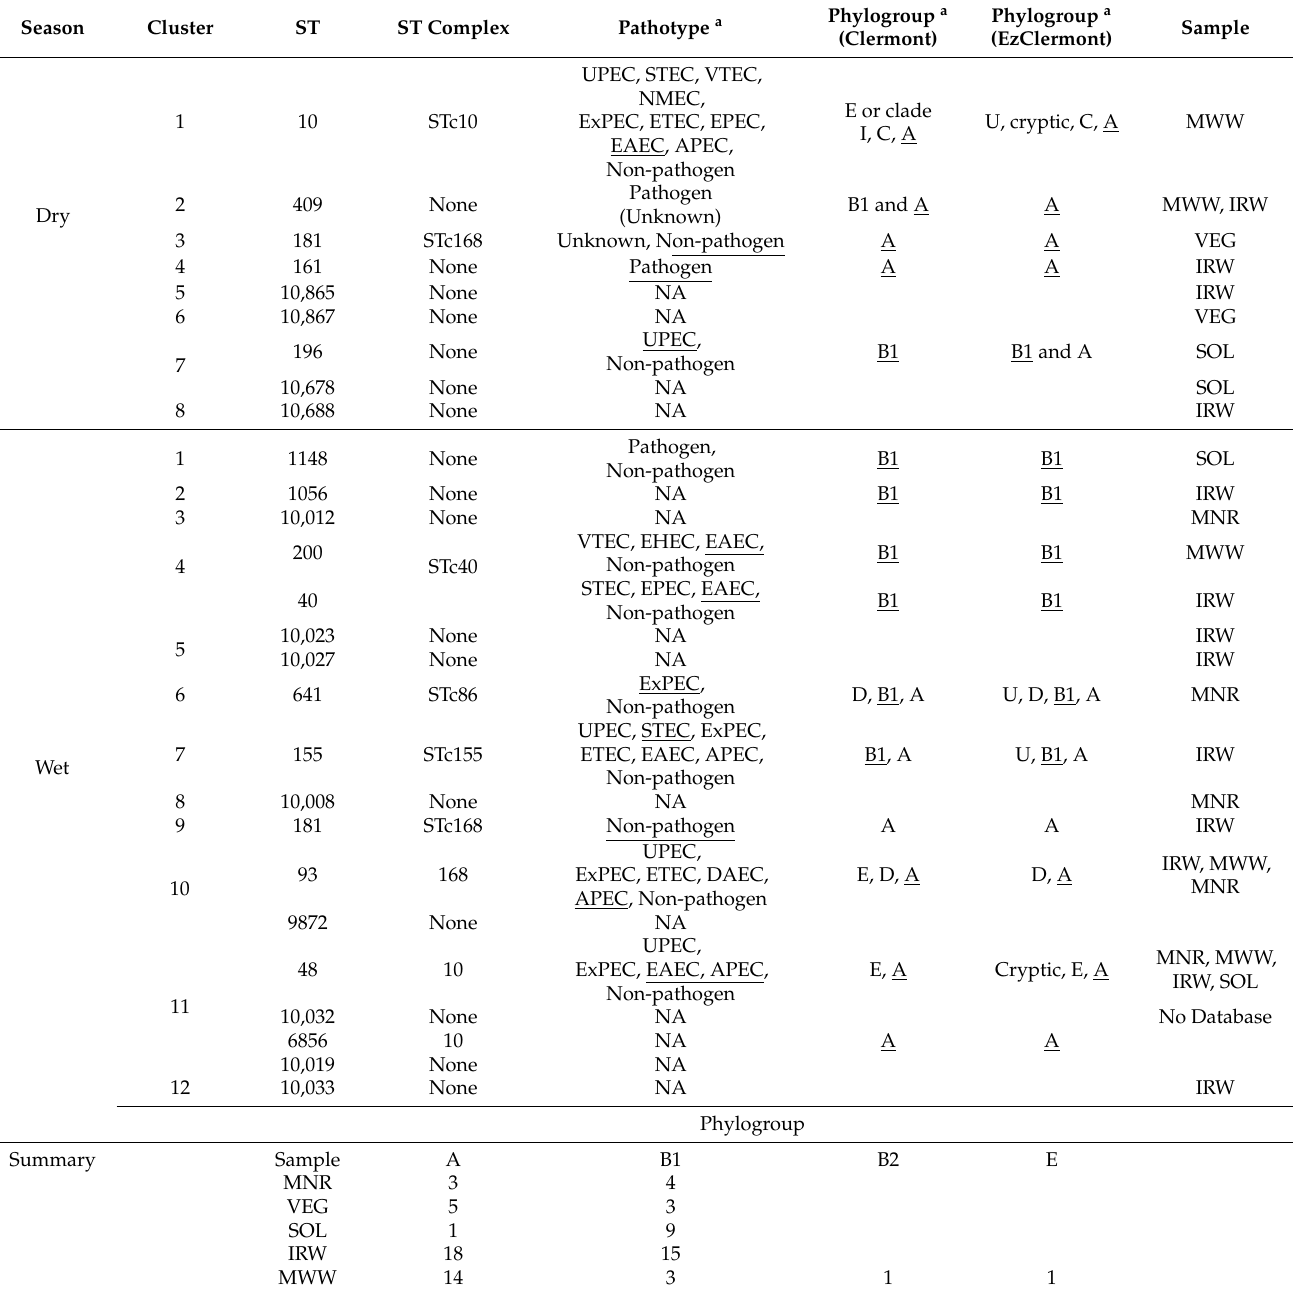
Table 3. Previously reported pathotype and phylogroups associated sequence types in clusters formed from phylogenic analysis. Season